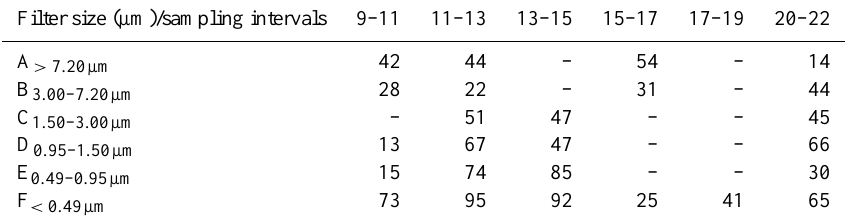
Figure 5. FLEXPART-WRF backward configuration of potential emission sensitivity plots for (a) 13 July (12:01:00), (b) 20 July (12:17:00) and (c) 21 July (12:01:00). The black line shows the ship track (note that these panels include the ship track after 23 July 2014 when high- volume sampling was not performed). The air mass residence time (seconds) before arriving at the ship location is shown with different colors. Numbers on the panels show the approximate lifetime and the center of the plume locations. Table 3. Biogenic fraction of non-sea-salt sulfate (%) for each size range of filter. There was not enough sample for isotope analysis for some